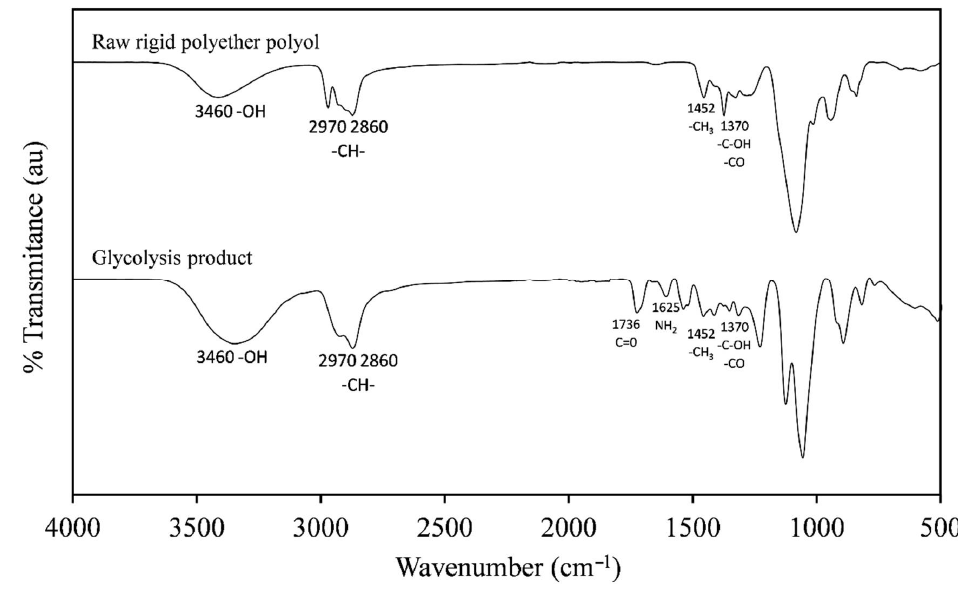
Figure 3. FTIR spectra of the raw polyol and the product obtained from the glycolysis reaction.